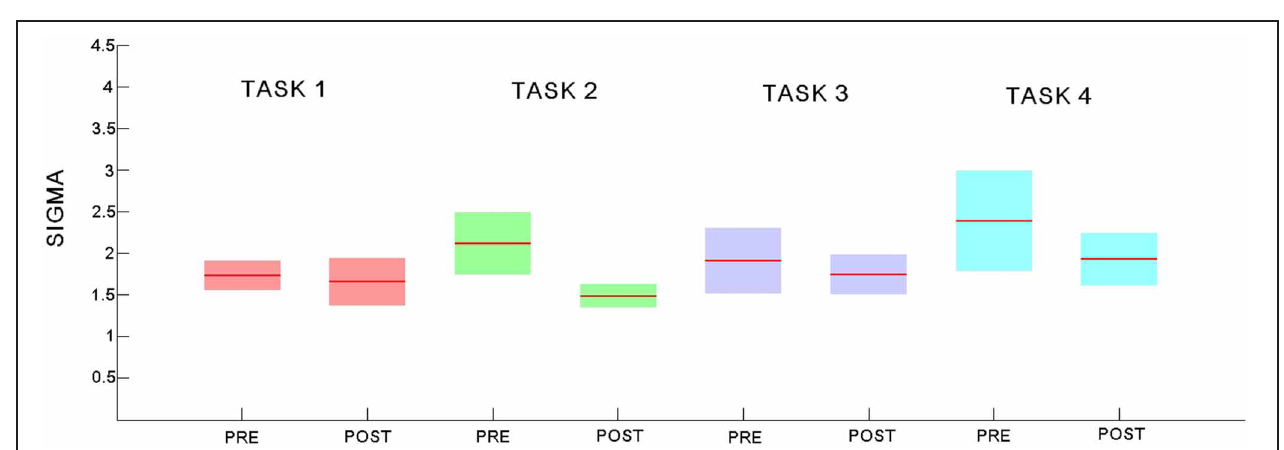
FIGURE 11 | Small world coefficient sigma for the pre- and post-task rest networks for each of the 4 experiments. Explicit SRTT task 1: red (pre-task on left and post-task on right); implicit SRTT task 2; green, visuo-motor